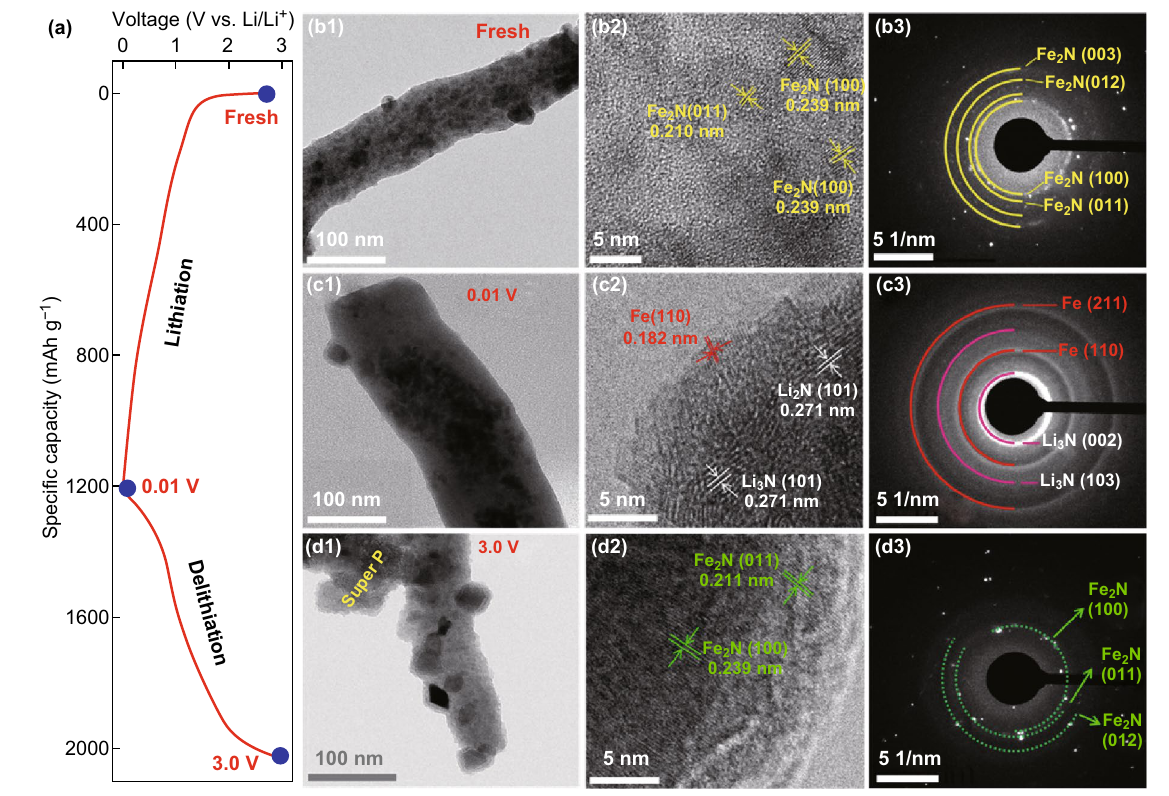
Fig. 5 a Initial discharge/charge curves of Fe 2 N@N-CFBs at 50 mA g −1 in the voltage range of 0.01 −3.0 V. b – d TEM, HRTEM, and SAED images of the